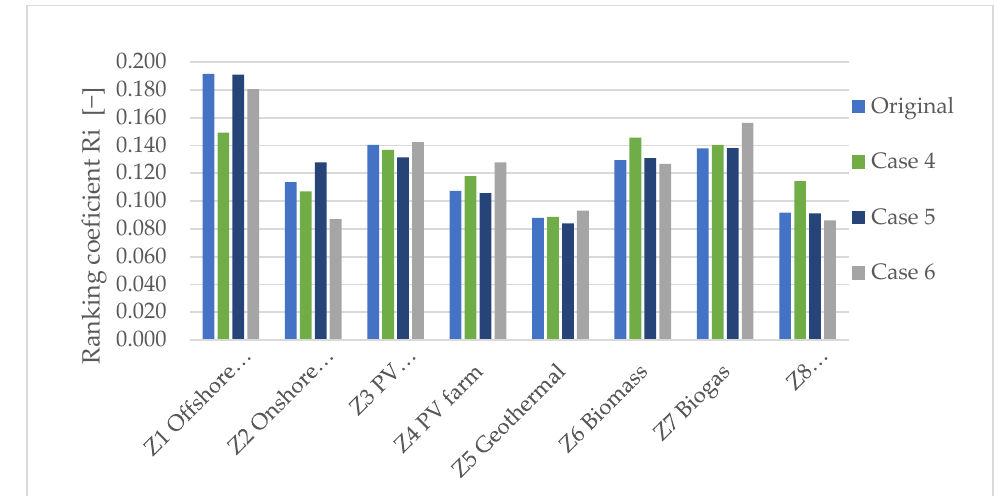
Figure 5. The impact of the criteria weights on the ranking coefficient, Cases 4–5 versus original case.